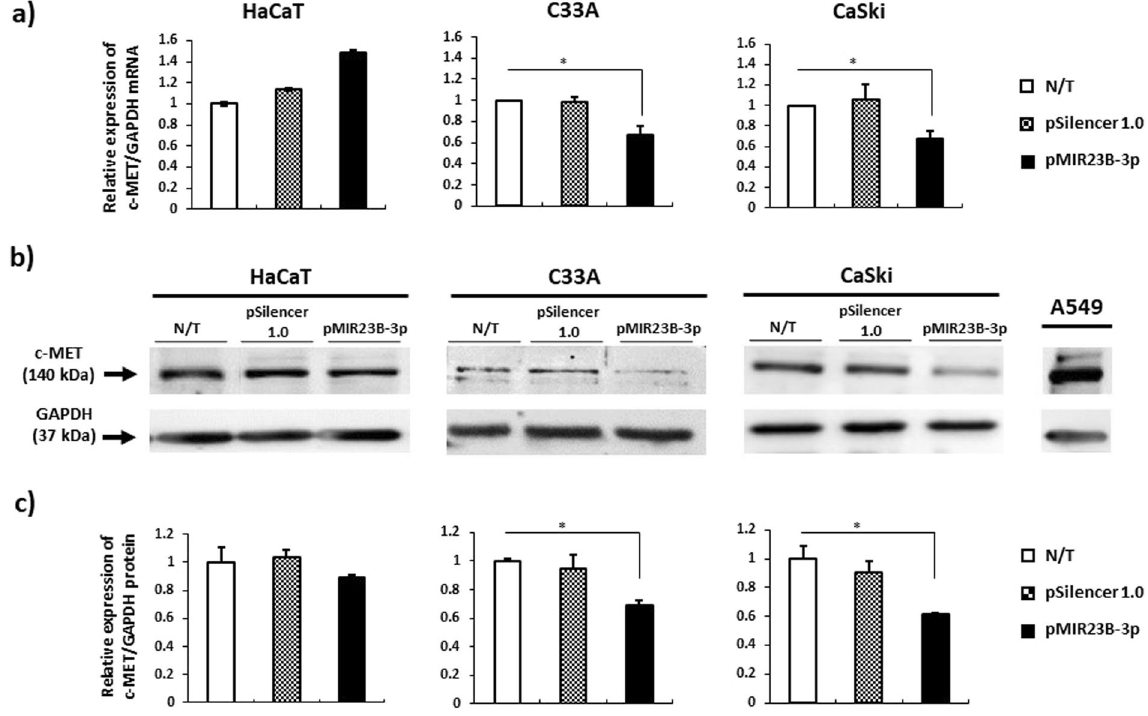
Figure 4. The overexpression of miR-23b-3p reduces the levels of c-Met mRNA and protein in C33A and CaSki cells. (a) miR-23b-3p significantly reduced the expression of c-Met mRNA. The levels of c-Met mRNA were determined via RT-qPCR and analyzed via the 2 −Δ Ct method. (b) In overexpression conditions, miR-23b-3p significantly reduces c-Met protein levels. The levels of mRNA and protein were normalized using GAPDH. The cell line A549 was used as a positive control for the expression of c-Met in the Western Blot assays. (c) Densitometric analysis of the expression of c-Met. N/T: non-transfected. The data are expressed as averages + SE. * p <